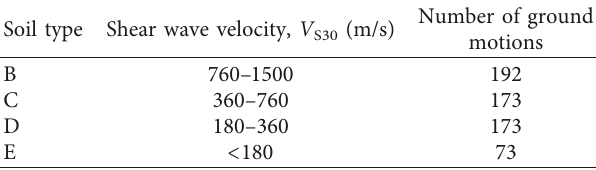
Table 2: Site classifications defined in NEHRP